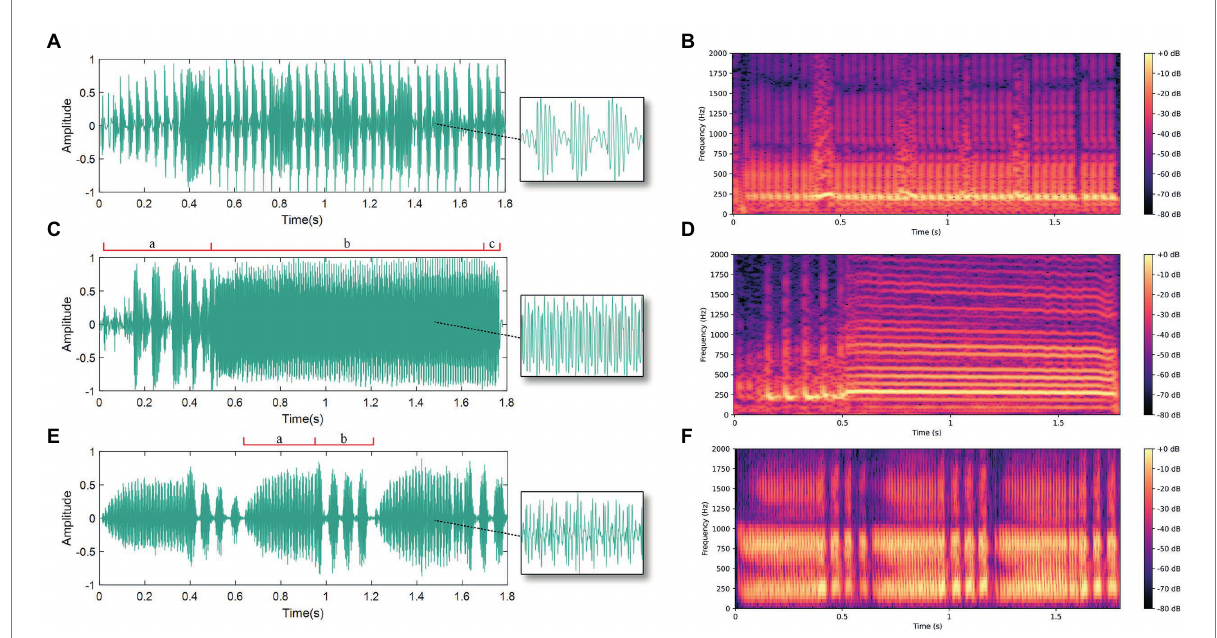
FIGURE 4 Oscillograms and spectrograms of male and female vibration signals: (A) Oscillogram of female courtship signal; (B) Spectrogram of female courtship signal; (C) Oscillogram of male courtship signal (divided into parts a, b and c); (D) Spectrogram of male courtship signal; (E) Oscillogram of male competition signal (divided into parts a and b); (F) Spectrogram of male competition signal.